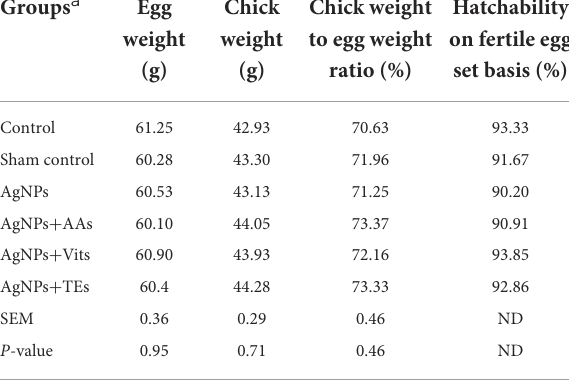
TABLE 1 Effect of in ovo administration of silver nanoparticles (AgNPs) and critical nutrients on hatchability parameters of vaccinated birds. Groups